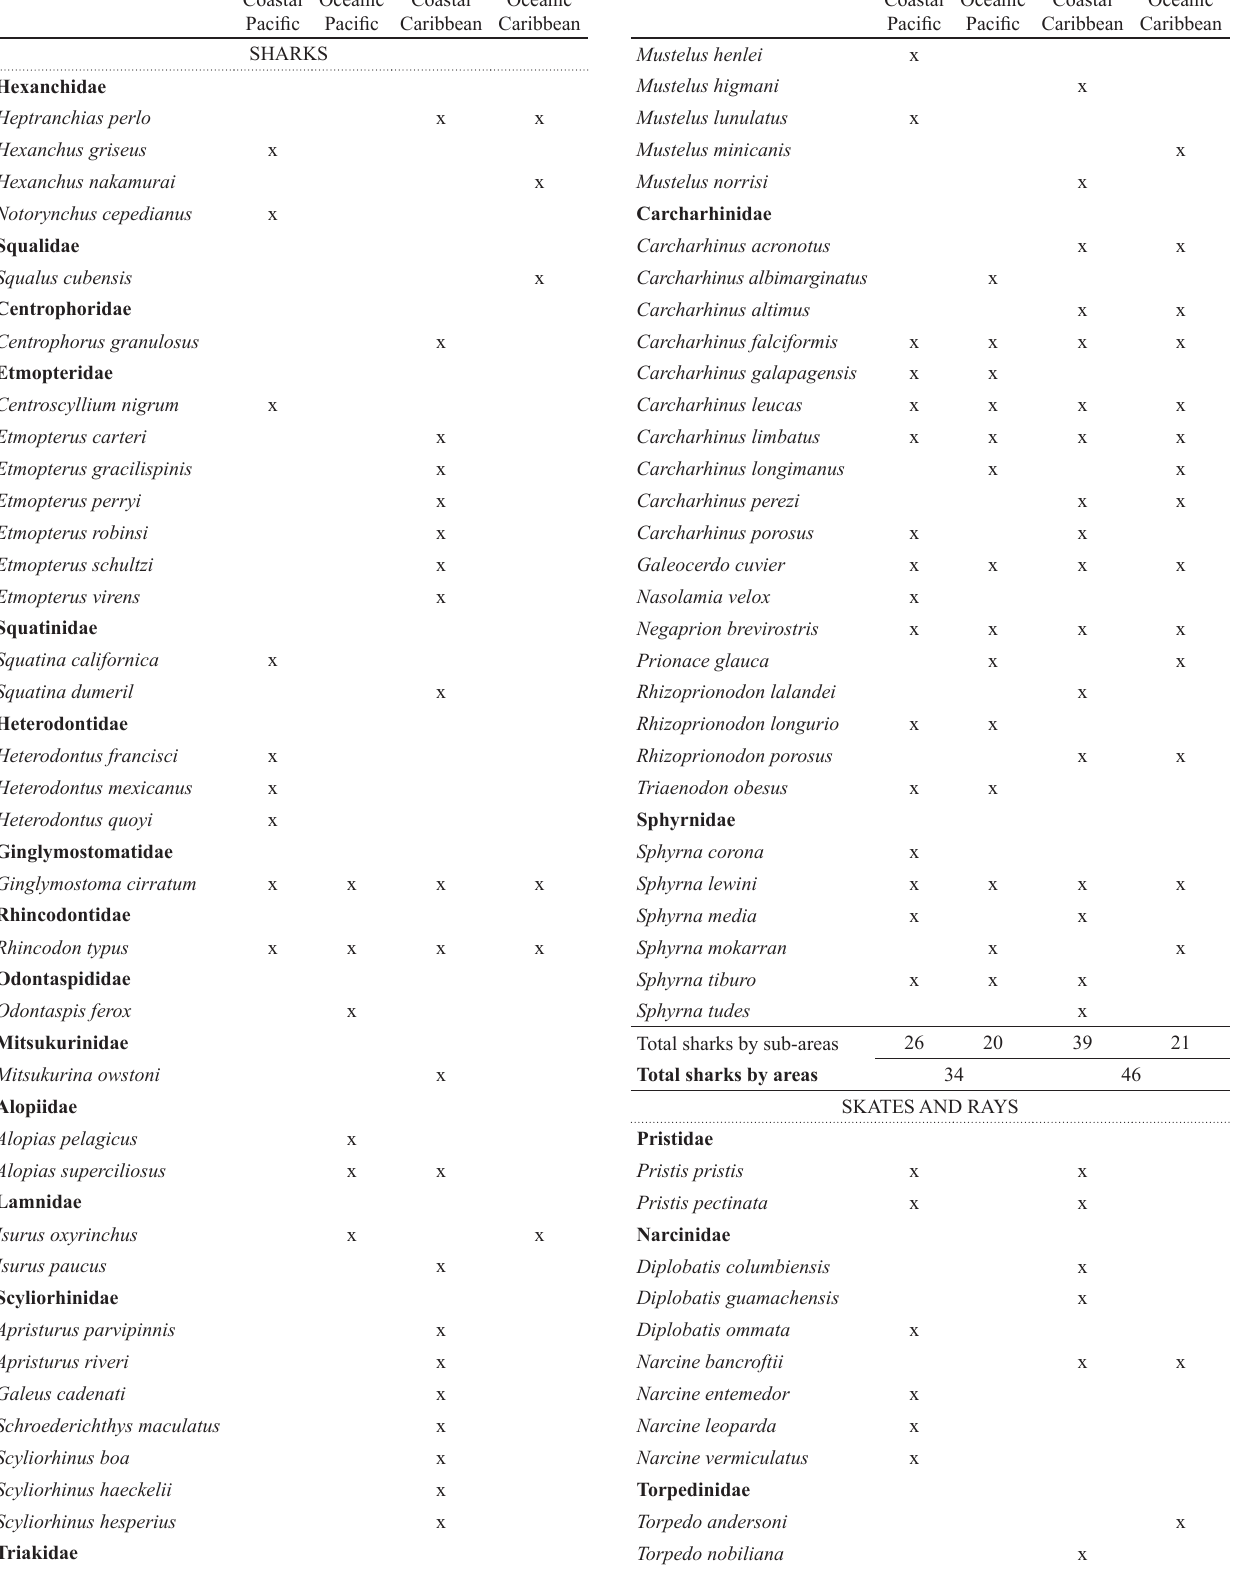
Table 1. Richness of genera and species of sharks and batoids in the Colombian Caribbean and